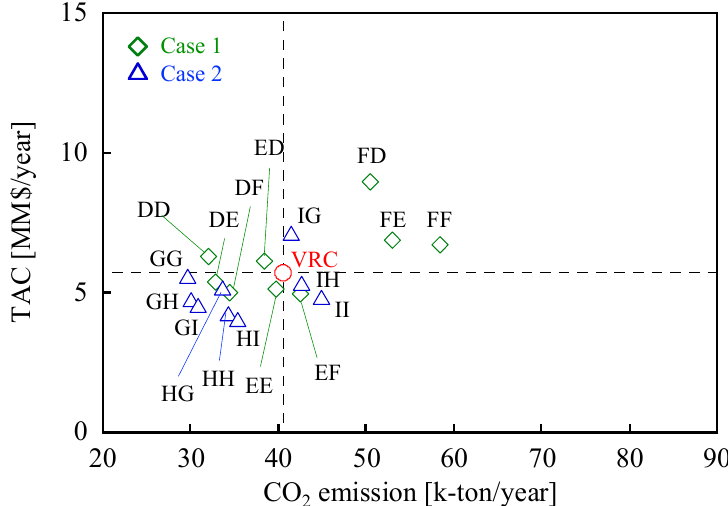
Figure 9. The relationship between CO 2 emissions and TACs for Cases 1 and 2. The membranes in Case 1 are D, E, and F (indicated by green diamonds), while those in Case 2 are G, H, and I (indicated by blue triangles).